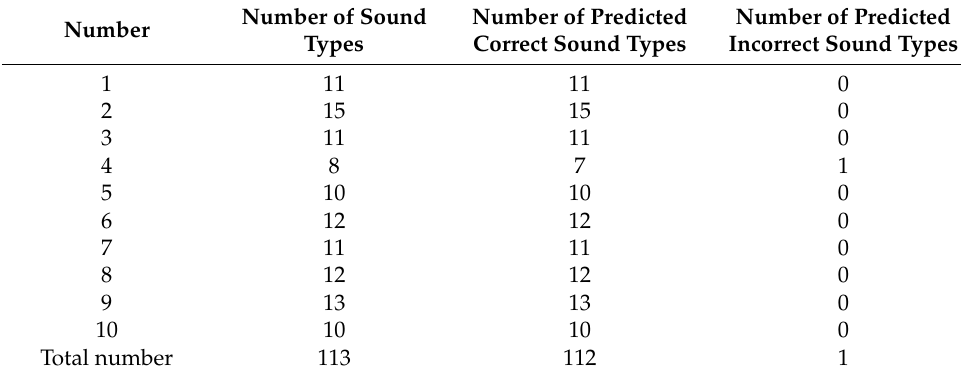
Table 12. Recognition results of ten segments of broiler sound